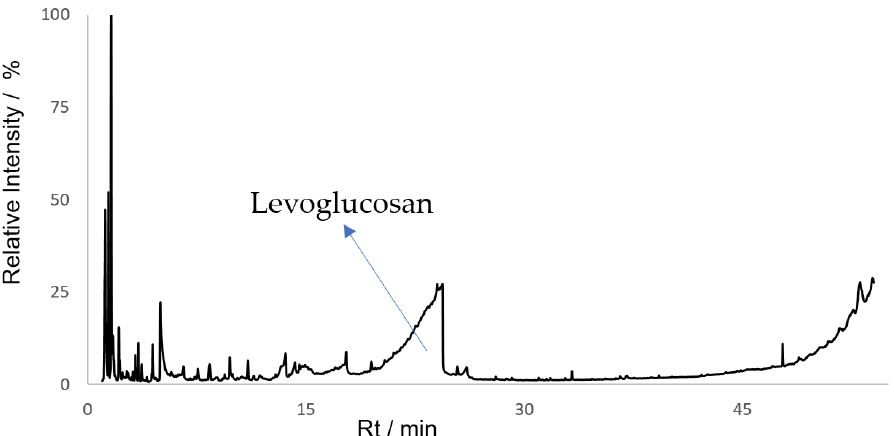
Figure 5. Chromatogram of warp yarn as structural unit of cotton cellulose in blend with polyester.